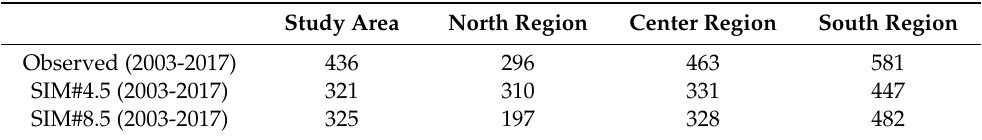
Table 5. Mean R-factor [MJ mm ha -1 h -1 yr -1 ] based on spatially distributed observations and simulated